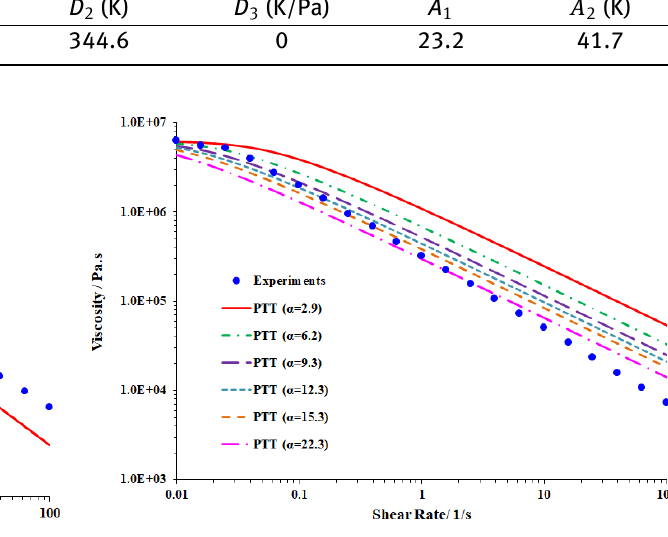
Figure 2: Comparison between measured viscosities at 115 ∘ C and simulations with fitted Cross-WLF model